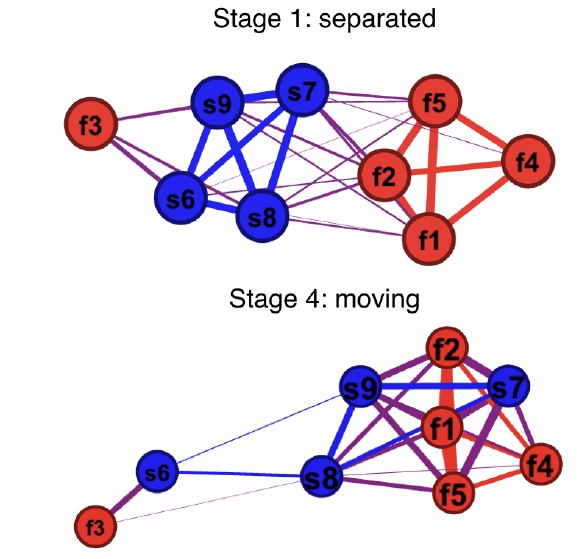
Figure 3. Network visualisations of the tempo similarity matrices in stage 1 ( top ) and stage 4 ( bottom ), in the game for second group. Node colors indicate group membership, thickness and also length of the edges reflect the tempo similarity with thicker and shorter edges reflecting closer tempo